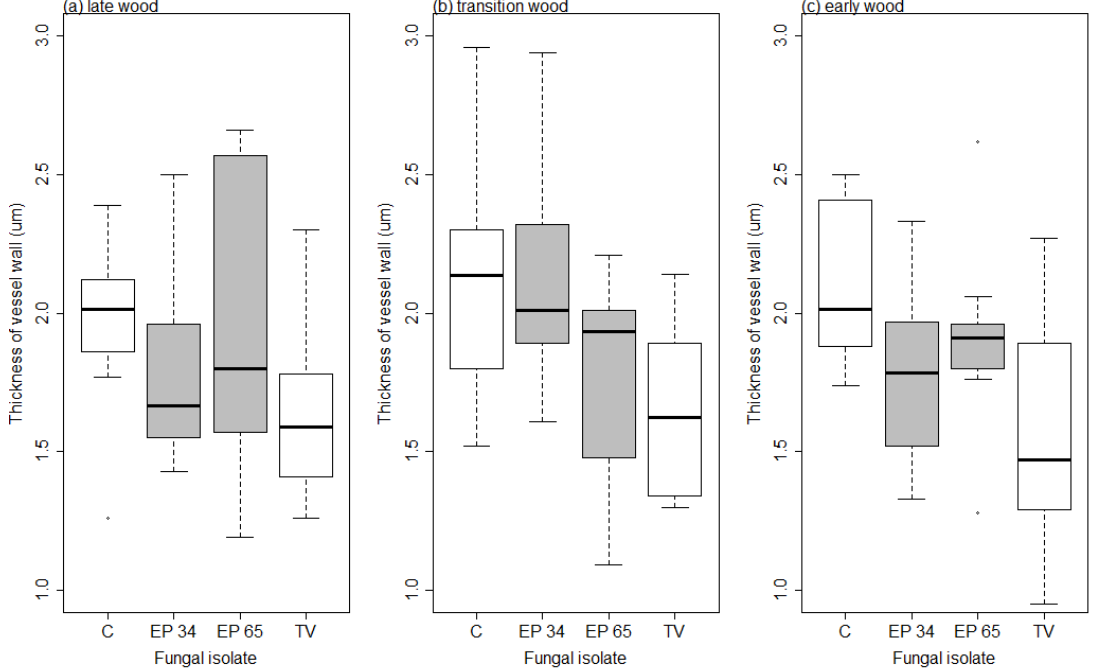
Figure 10. Vessel wall thickness ( µ m) in ( a ) late wood, ( b ) transition wood, and ( c ) early wood after exposure to di ff erent fungal isolates (see Table 1 for labels of isolates; boxes of E. parasitica isolates are grey). Boxplot represents minimum, first quartile (Q 1 ), median, third quartile (Q 3 ), and maximum value.